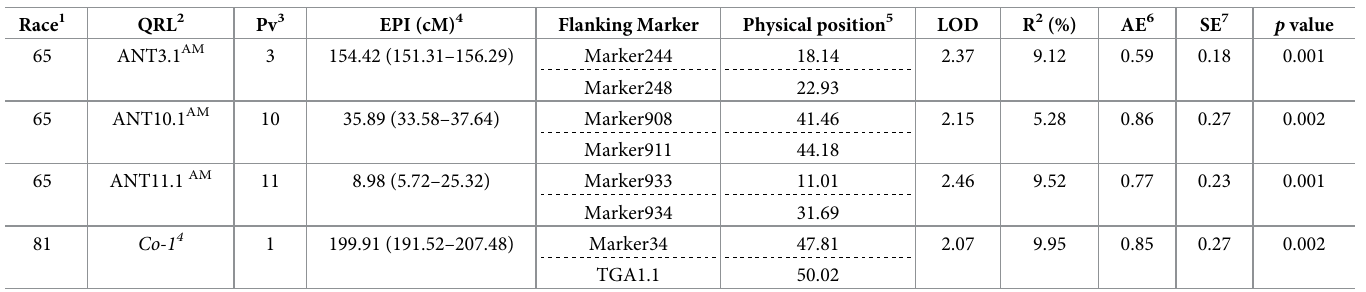
Table 2. Quantitative resistance loci association results